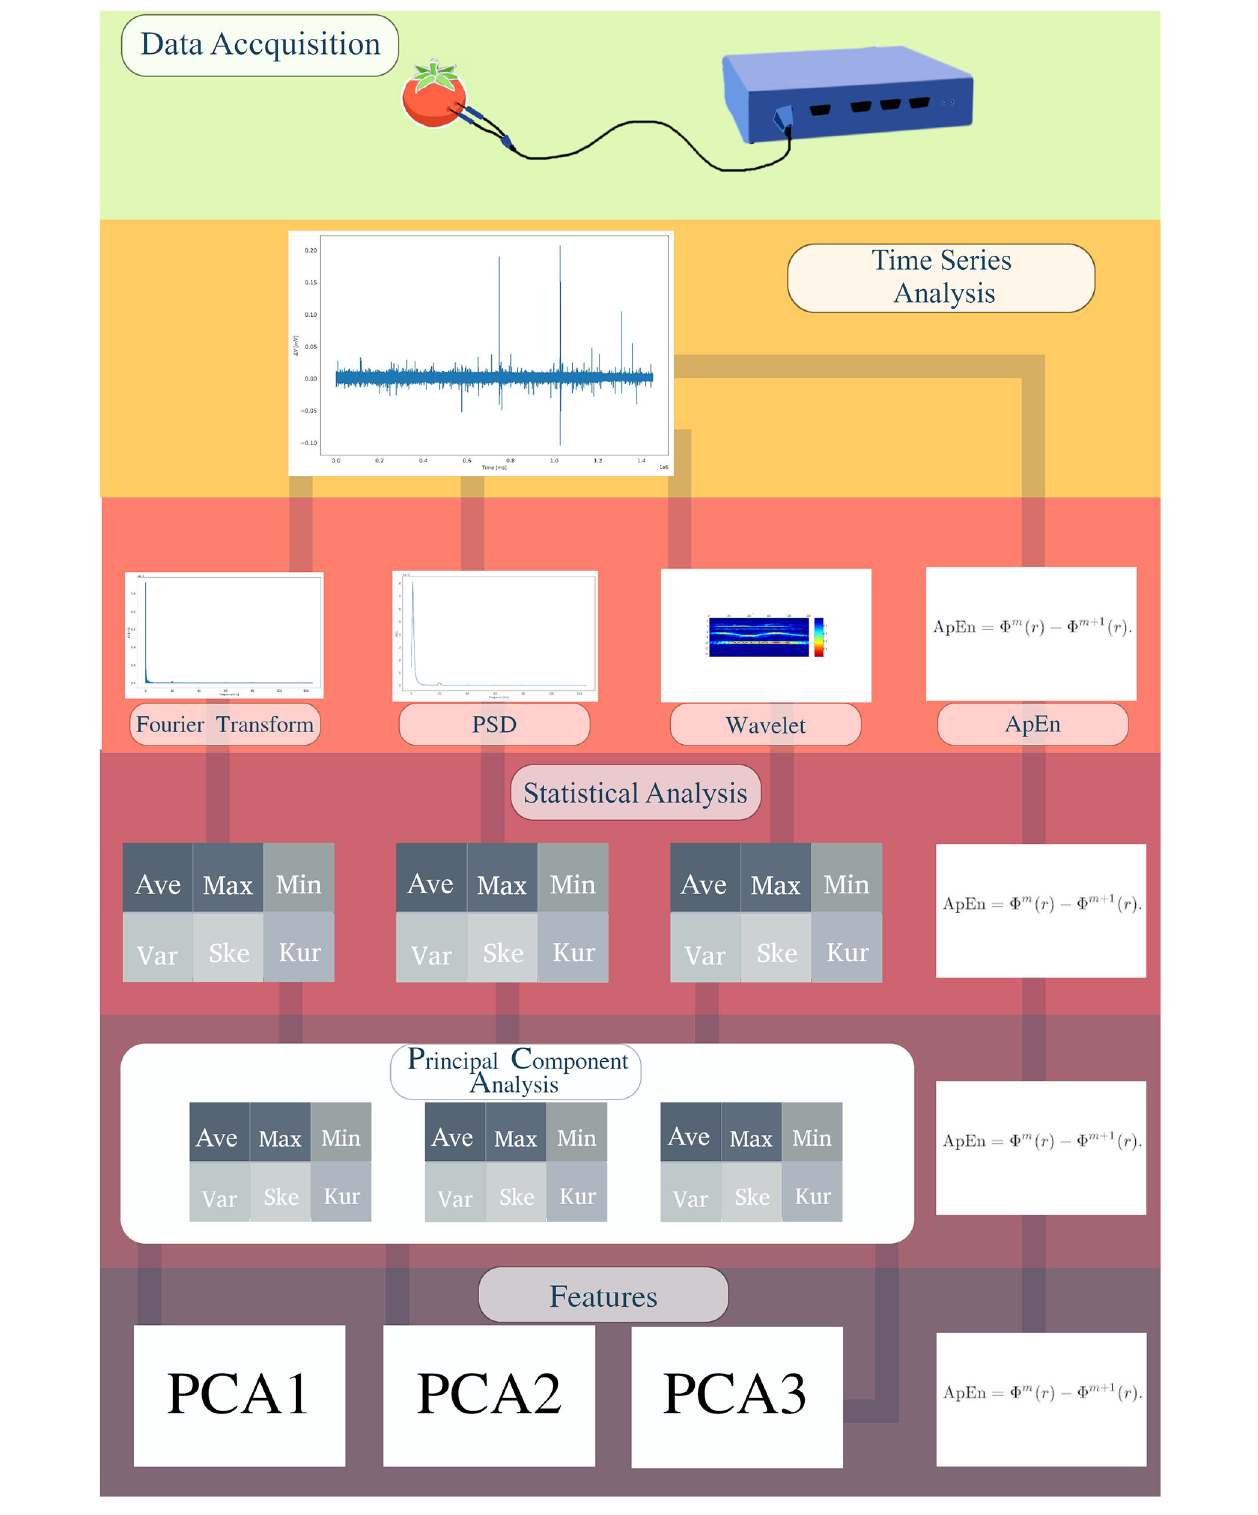
FIGURE 2 | Scheme representing the acquisition of features for Machine Learning analysis. Fruit electrical signals were recorded with an electronic system for data acquisition (MP36). The bioelectrical runs were analyzed as voltage variation ( µ V) time series (TS). Afterwards, the approximate entropy (ApEn), Fourier transform (FFT), Power Spectral Density (PSD), and Wavelets were calculated. Except for ApEn, the descriptive analyzes of average, maximum value, minimum value, variance, skewness, and kurtosis were calculated. With these results, PCA was calculated and PCA1, PCA2, and PCA3 obtained. Finally, we obtained three PCAs and ApEn as ML